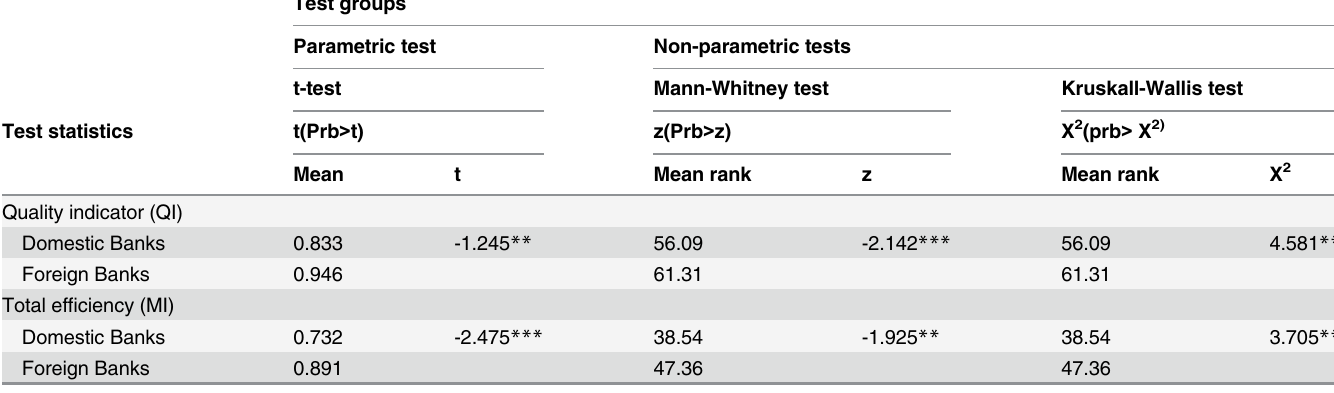
Table 7. Robustness of